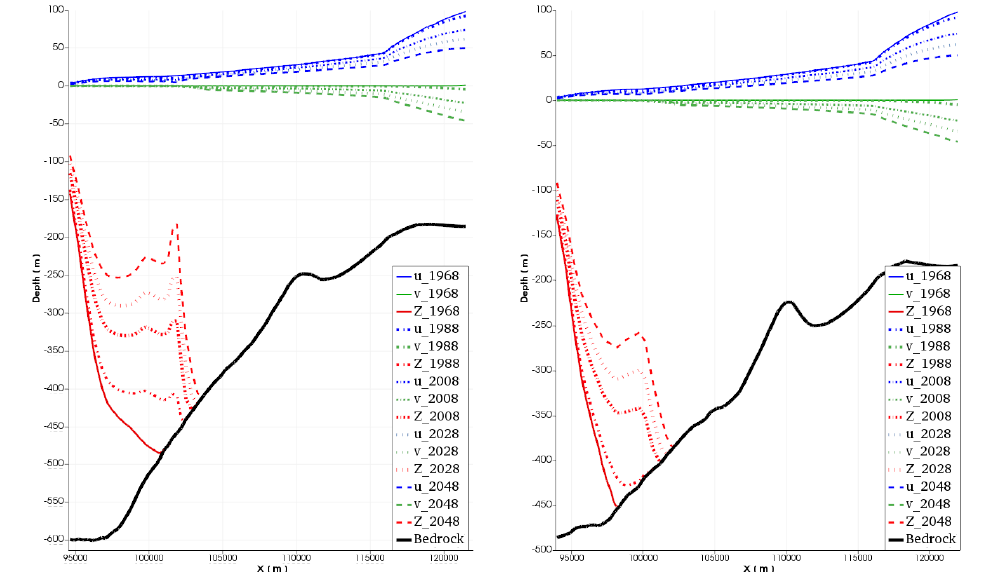
Figure 16. Vertical cross section showing the interface position (red line), the free surface position (blue line) and the variation of the saltwater hydraulic head (green line), for different times: cut on the levels 2 ( left ) and 3 ( right ).